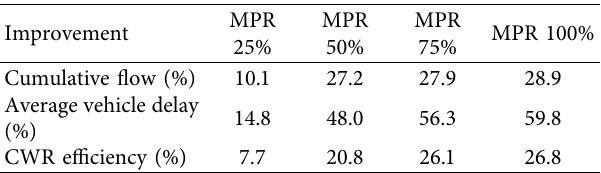
Table 6: Efect of CWR intersection signal control: intersection type